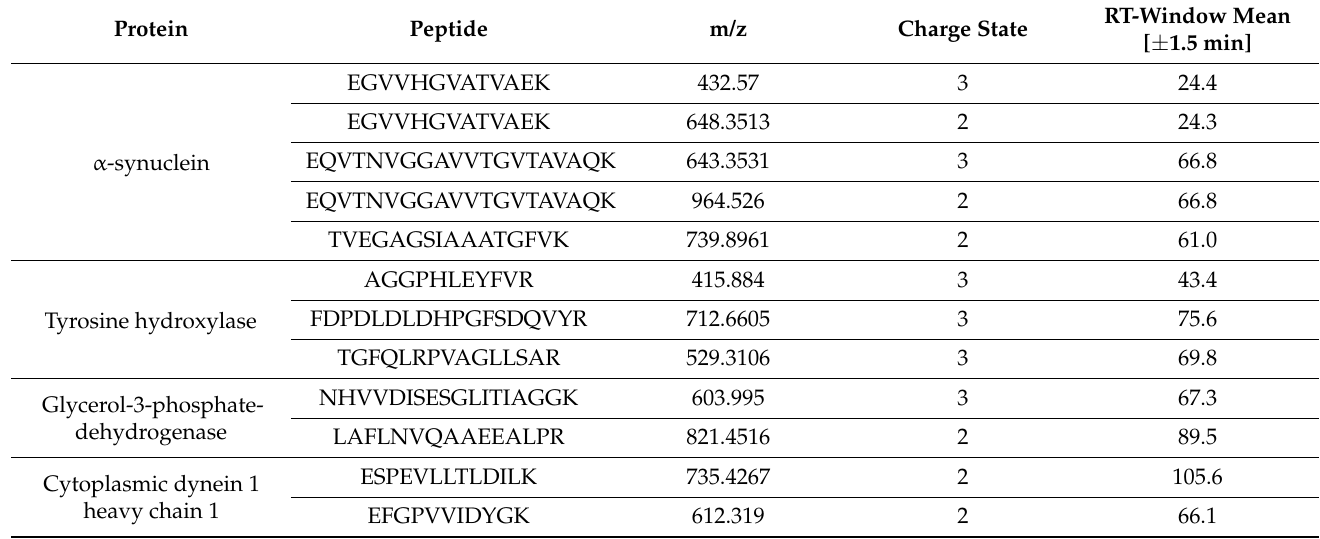
Table 2. Inclusion list for parallel reaction